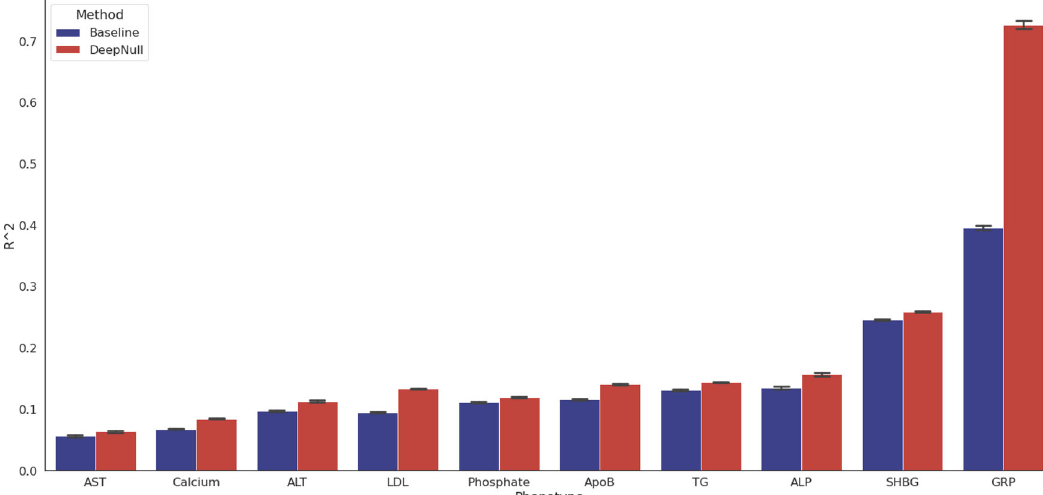
Fig. 3 DeepNull improves phenotype prediction compared to Baseline. The X -axis provides the phenotype names and the Y-axis is the R 2 where R is Pearson ’ s correlation between true and predicted value of phenotypes. Center of each bar indicates the computed R 2 over all samples and the error bars indicate the standard error. Standard errors are computed by performing bootstrapping for each phenotype ( n = 1000 bootstrapping trials). Phenotypic abbreviations: alkaline phosphatase (ALP), alanine aminotransferase (ALT), aspartate aminotransferase (AST), apolipoprotein B (ApoB), glaucoma referral probability (GRP), LDL cholesterol (LDL), sex hormone-binding globulin (SHBG), and triglycerides